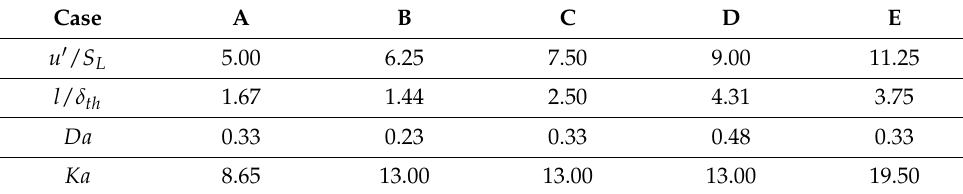
Table 4. List of initial simulation parameters and non-dimensional numbers.